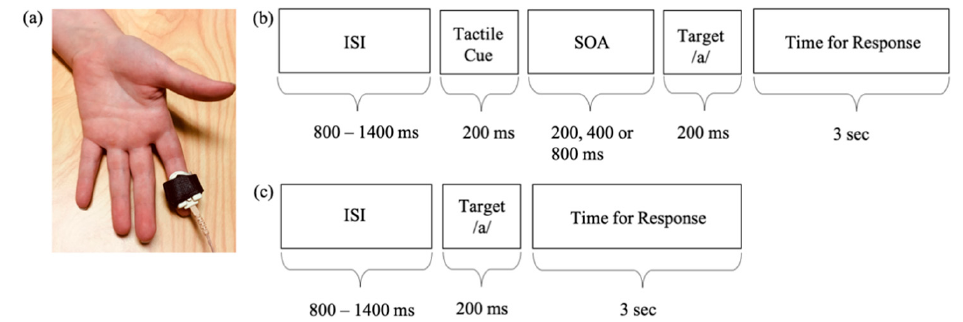
Figure 1. ( a ) Mechanical tactor used to deliver the tactile cues. Illustration of trials with ( b ) and without ( c ) tactile cues. ISI, Interstimulus Interval; SOA, Stimulus Onset Asynchrony